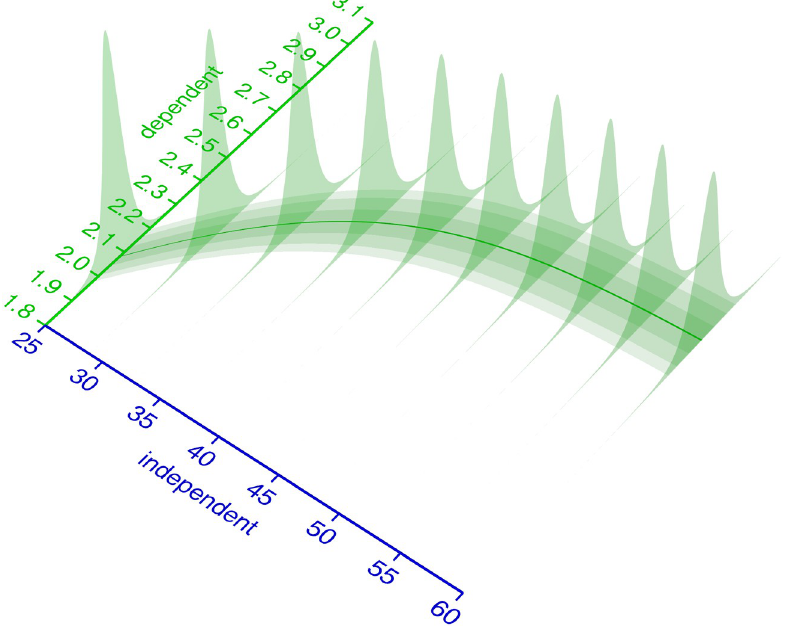
Fig 2. Relationship of independent and dependent variable. The distribution of measurement responses (dependent variable) can be modeled as a function of the independent variable. This measurement response probability distribution (here: Student- t ) is parametrized by its parameters the mean μ (solid green line) and spread parameters σ and ν . Some or all of the distributions parameters are modeled as a function of the independent variable.